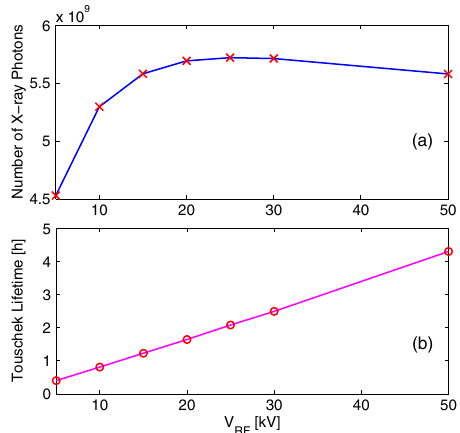
. Part (b) shows the rf . The corresponding Touschek rf